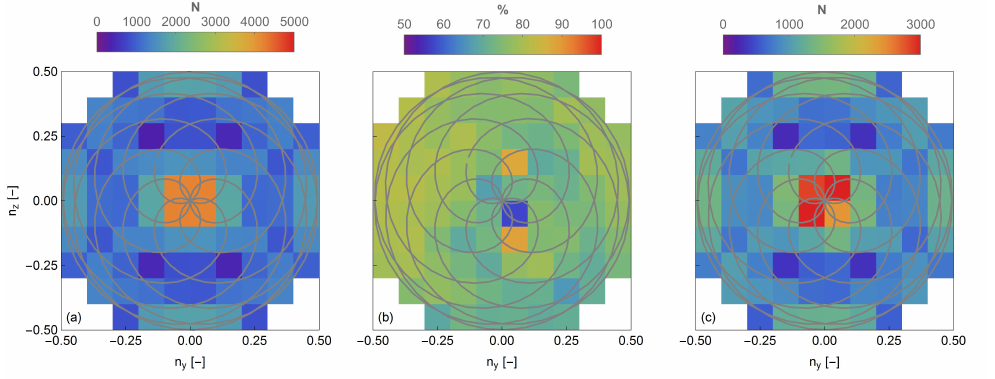
Figure 11. ( a ) Number of measurements, ( b ) data availability, and ( c ) the eventual number of wind observations using a 10 × 10 grid based on the transverse 𝑛 𝑦 and vertical 𝑛 𝑧 components of the line-of-sight unit vector, over a 10 min period. The grey rosette pattern represents the scanning trajectory. The data corresponds to a case when the mean wind speed was 7 ms − 1 and in the direction of 256 ◦ .